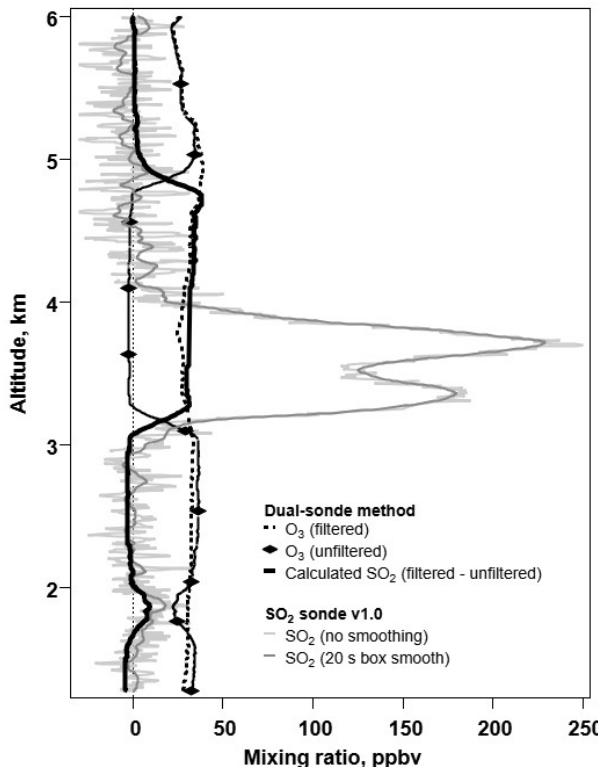
Figure 5. The profiles of a triple-sonde payload, which consisted of a dual sonde in tandem with an SO 2 sonde v1.0, launched from the Universidad de Costa Rica’s campus in San Jose (approximately 31km downwind of the volcano Turrialba) on 23 March 2018.